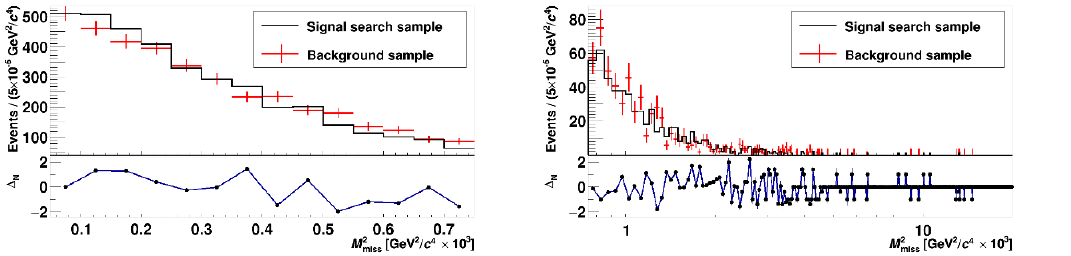
Figure 3 . M 2 distribution of samples for A 0 search (black) and background (red, with error miss bars). The scaling factors are evaluated in the region shown in the left panel. The search region is shown in the right panel. In the bottom panels, the di(cid:11)erence (cid:1) N between the two M 2 in units of its standard deviation is